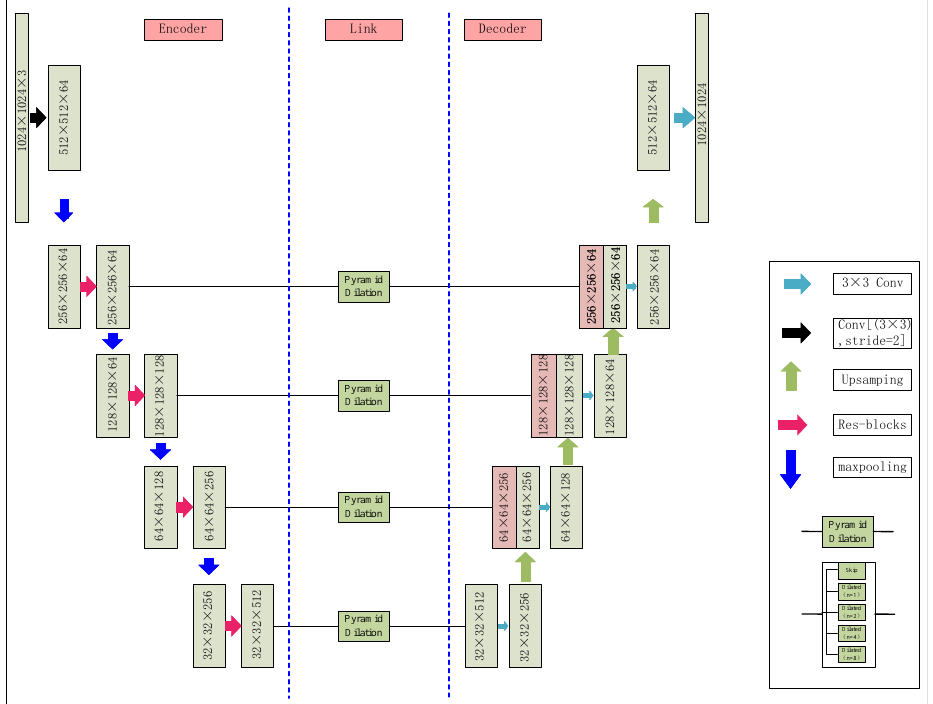
Figure 4. The architecture of the weakly supervised